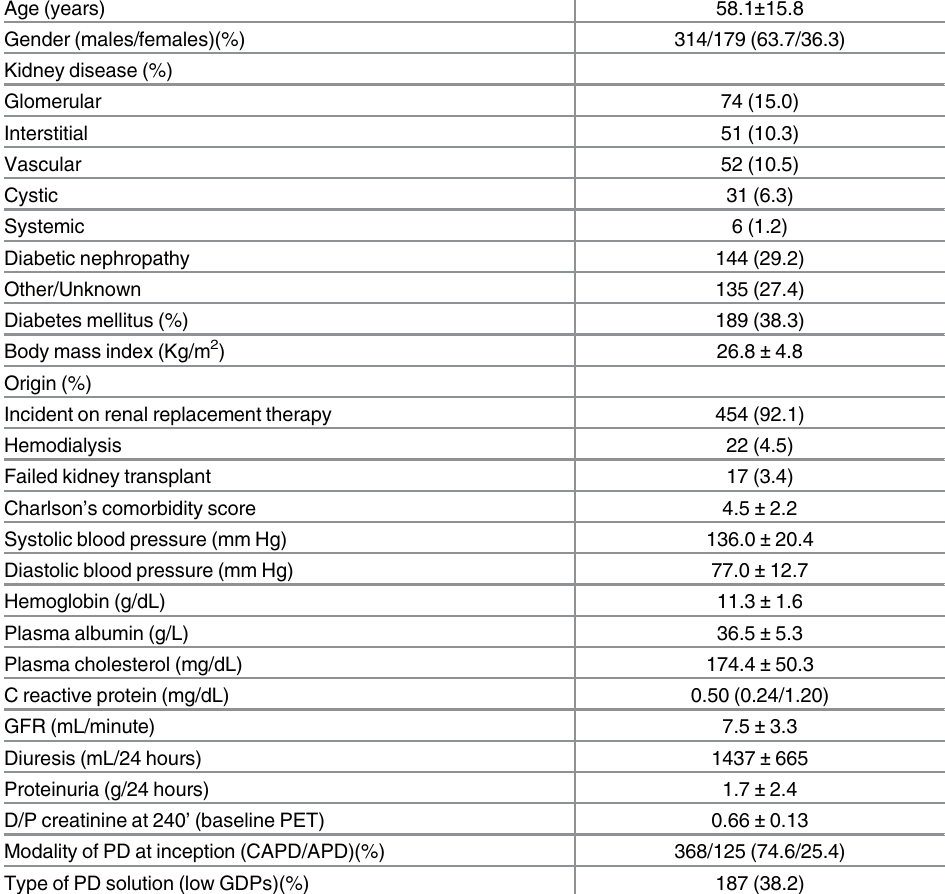
Table 1. Clinical and demographic characteristics of the study